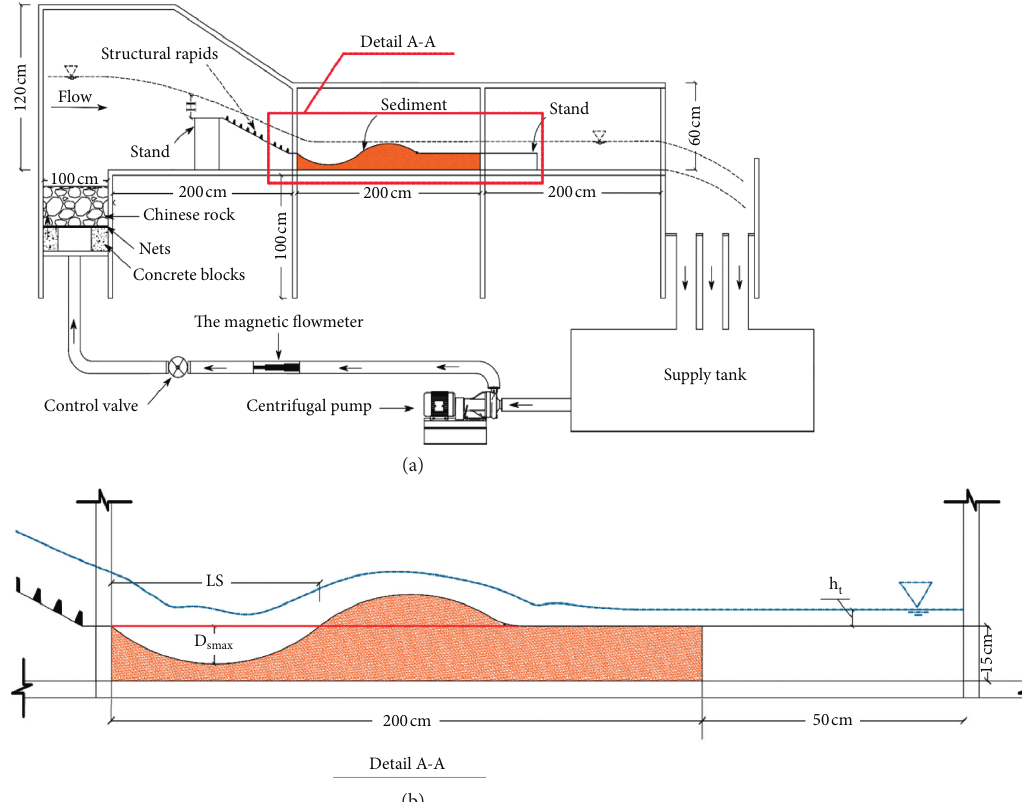
Figure 3: The detail of experimental flume and the place of installing the chute structure: (a) Longitudinal profile of the laboratory flume and equipment used with baffle block chute and (b) sediment bed downstream of the chute.